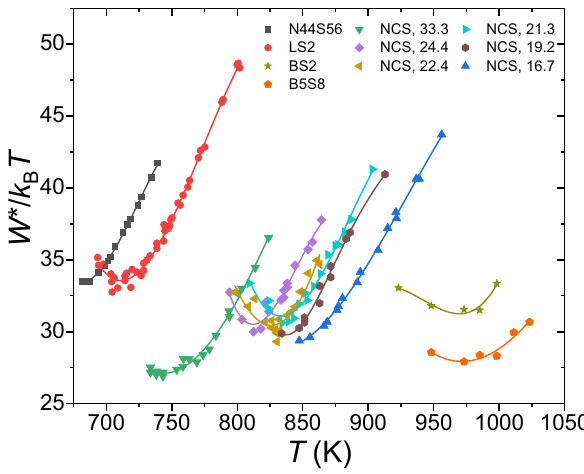
Fig. 2 The number of nuclei per unit volume as a function of nucleation time at 948 K for the 5BaO ∙ 8SiO 2 glasses. The black points are the new data obtained here and the red points are the data from an earlier study 10 (see inset, reproduced from ref. 10 with permission from Elsevier). The dashed lines show the linear fi ts in the steady-state range. (The error bars indicate the